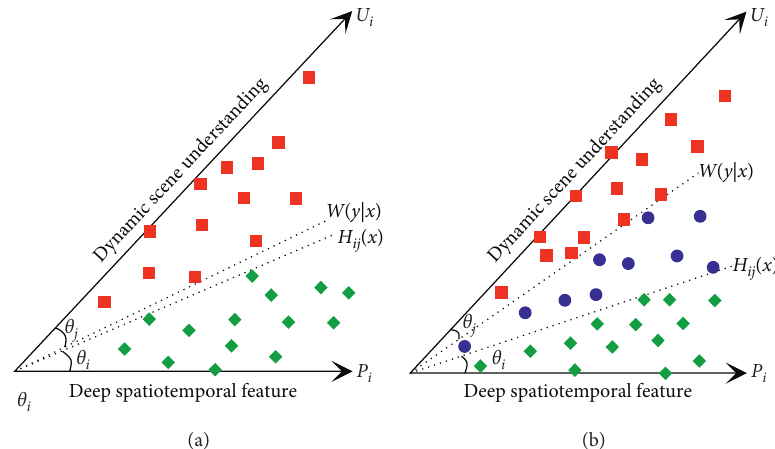
Figure 3: Normalized results of hidden and visible layer of deep learning algorithm. (a) Hidden layer. (b) Visible